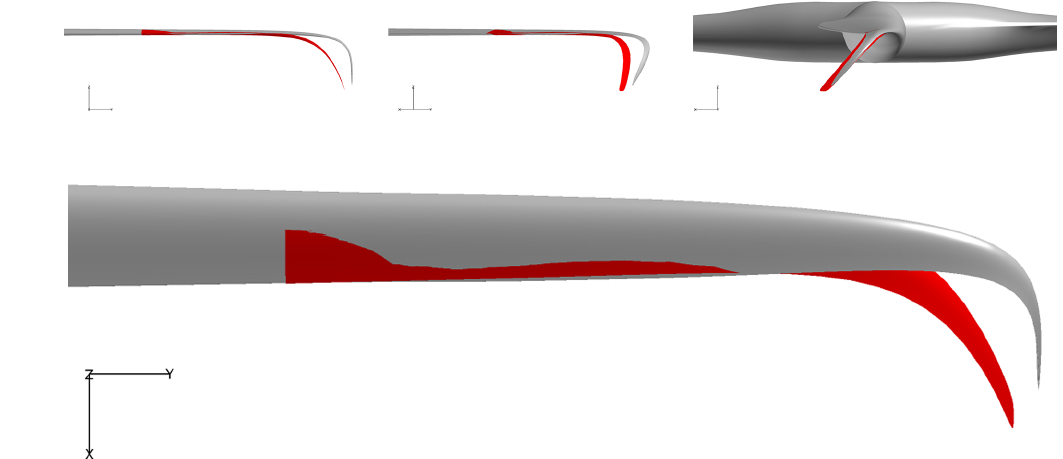
Figure 15. Resulting tip shape from the present study (red) compared to the surrogate-based design by Zahle et al. (2018) (gray). Both results exhibit maximally allowed curvature by their respective parametrization. As seen, the curvature from the present work (red) is not a true 90 ◦ winglet as in the study by Zahle et al. (2018), signifying that one should expect a difference in final possible improvement (final results are 1 . 12% and 2 . 6%, respectively). The upper three figure panels show different views in the rotor plane, whereas the lower panel is in the upstream